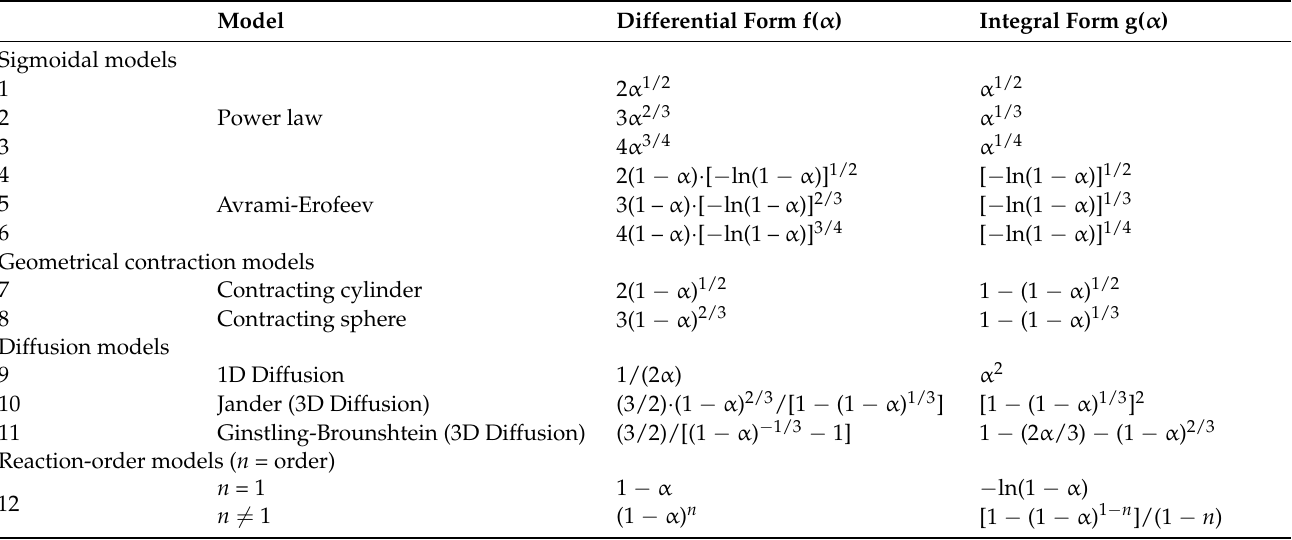
Table 1. The solid-state reaction